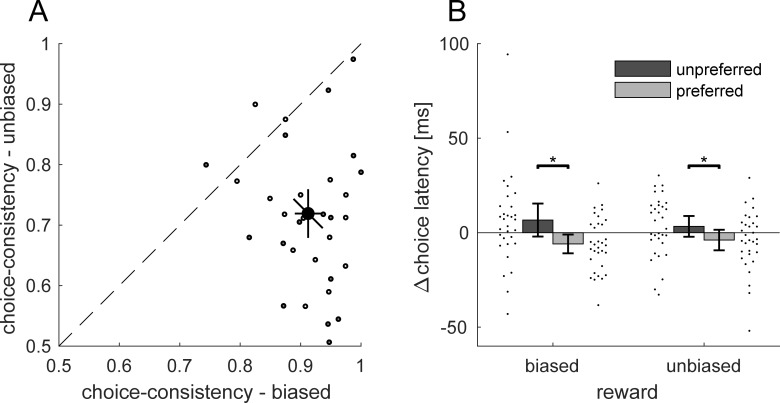
Choice behavior.(A) Choice-consistency expressed as proportion preferred target chosen for the biased and the unbiased reward condition. Open and grey-filled circles denote participants who started with the unbiased and biased condition respectively. The black symbol indicates the mean choice-consistency across all participants. The diagonal error bar denotes the variability of the difference between the two measures and has to be compared against the dashed diagonal. (B) Biased and unbiased choice-trial latencies split in preferred (light) and unpreferred (dark) targets. Data are plotted as the difference to the individual mean. All error bars denote 95% confidence intervals. Black data points next to each bar graph denote values of individual participants in that respective condition. Asterisks indicate a significant difference (p < 0.05).